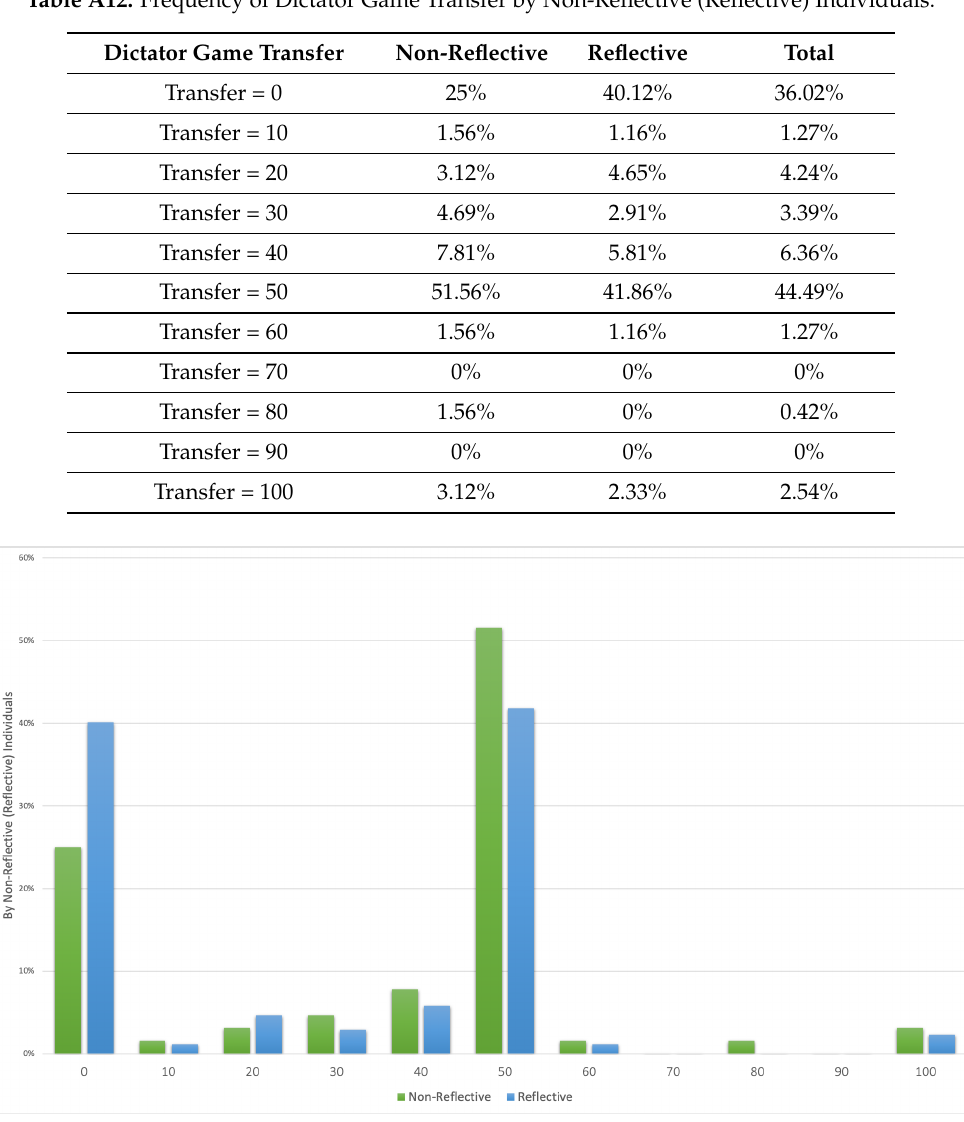
Table A12. Frequency of Dictator Game Transfer by Non-Reflective (Reflective) Individuals.